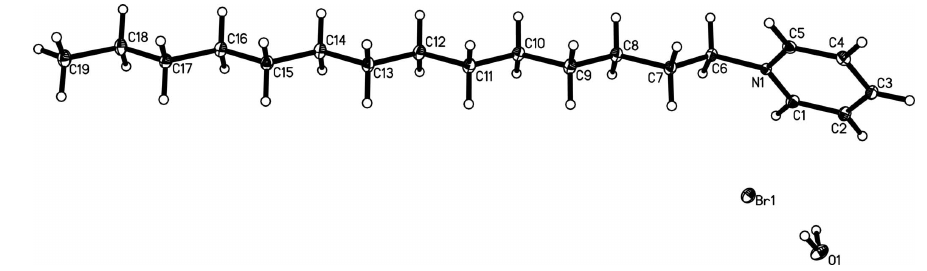
Figure 1 The molecular structure of (I) with 50% probability elipsoids for the non-hydrogen atoms.